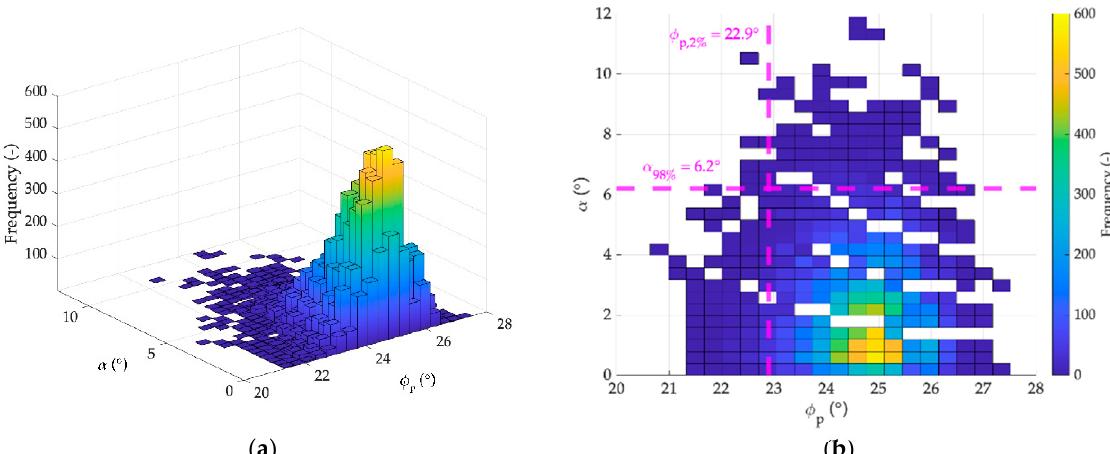
Figure 5. Example of the frequency distribution obtained for the set of 20,000 launches described in Figure 4: ( a ) three- dimensional histogram; ( b ) two-dimensional view of the same histogram. The magenta vertical and horizontal lines highlight the value of φ p ,2% and α 98% ,